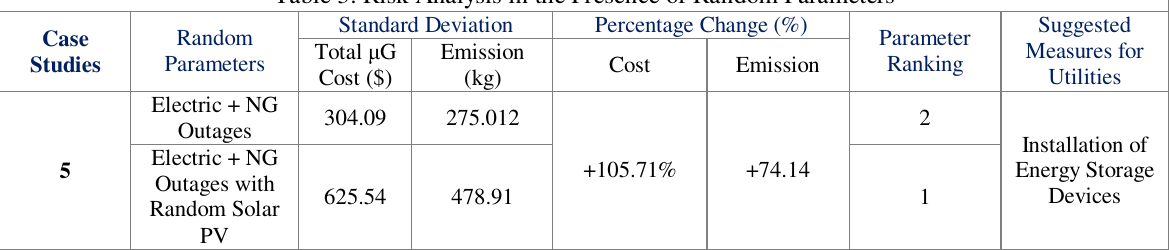
Table 3: Risk Analysis in the Presence of Random